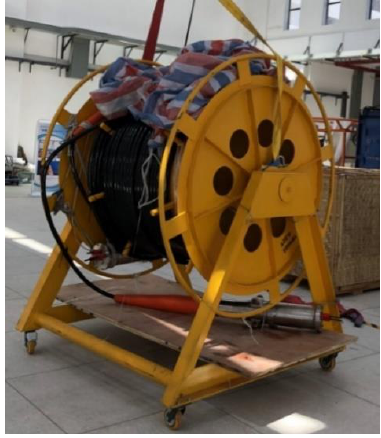
Figure 10. Cable and cable tray for inshore test.